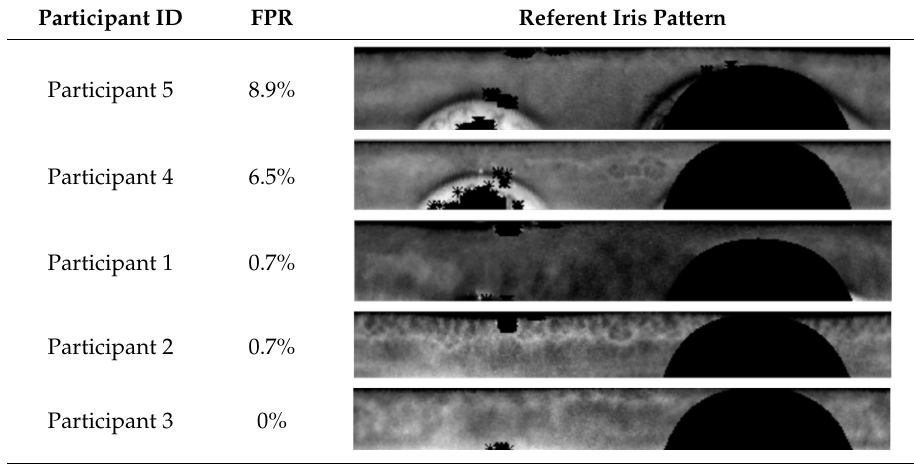
Table 2. Referent iris patterns of five participants, sorted in descending order of the measured FPR of eye torsion